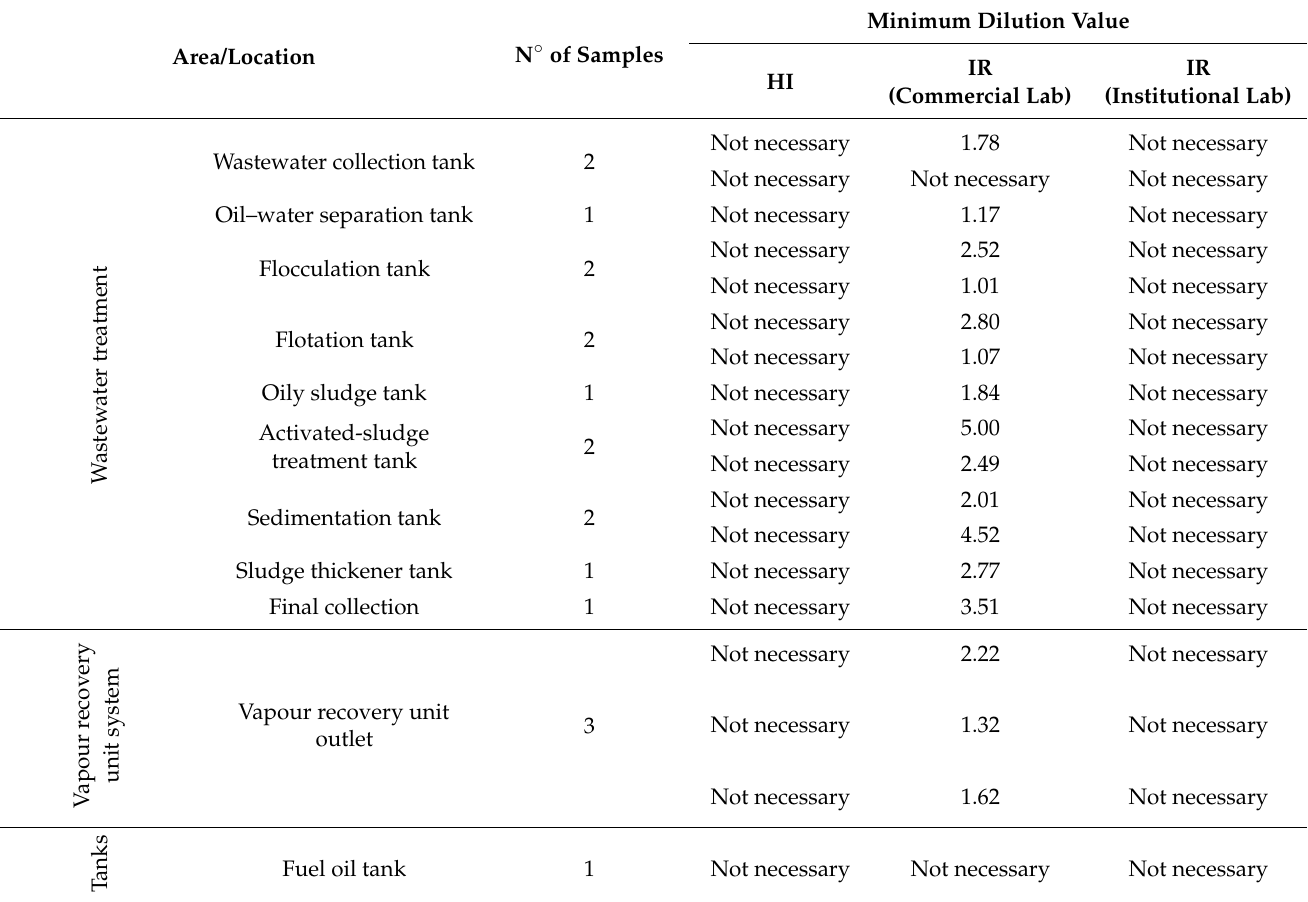
Table 4. Minimum dilution values for the samples considered. If a sample respects the acceptability criteria, a minimum dilution value is not